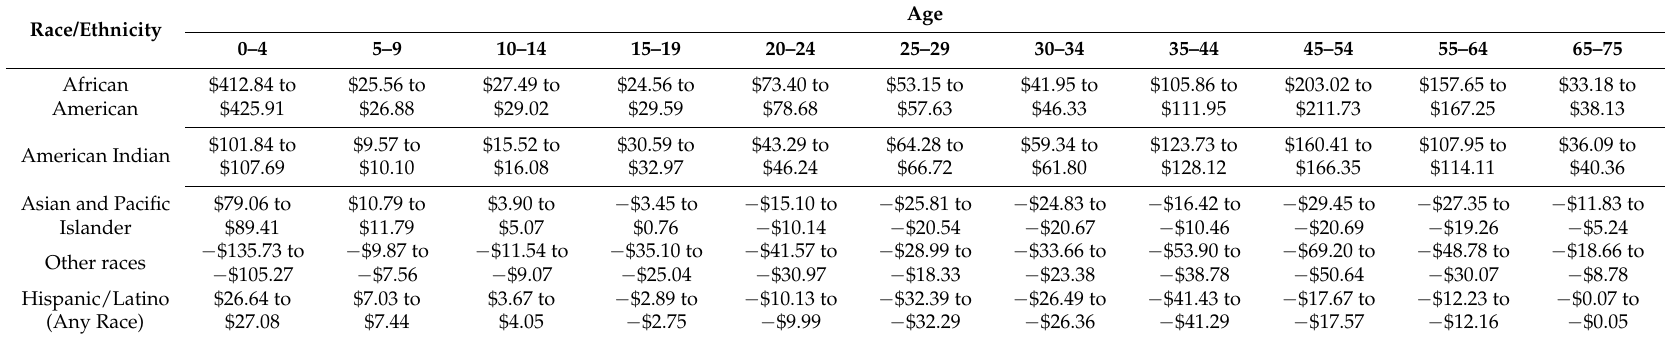
Table A2. Annualized estimated economic benefits from lives saved among minorities in Minnesota, by Age, 2011–2015 (unit: $1 million, adjusted by Medical Service Price